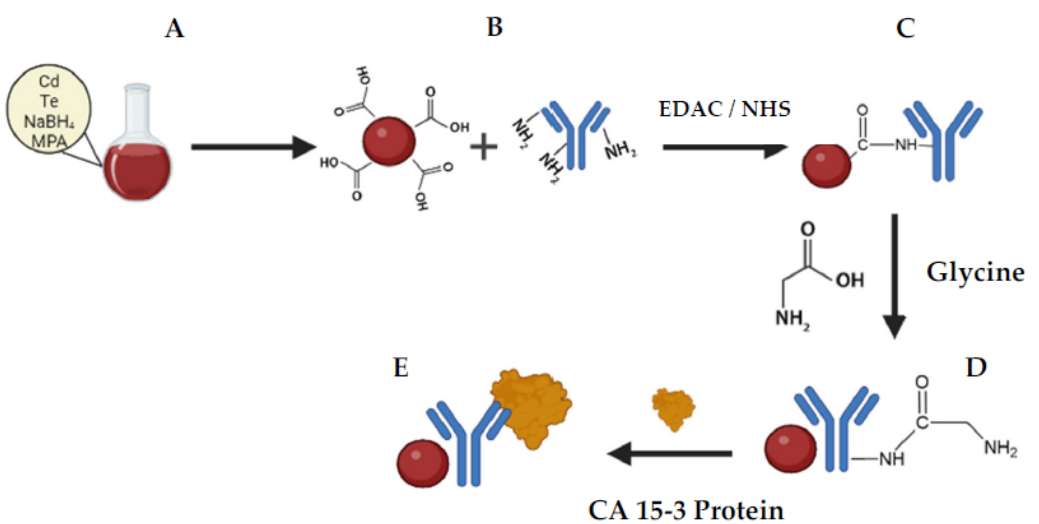
Figure 1. Schematic representation of the synthesis of the QD nanoparticles and preparation of the QD conjugates. ( A ) QD synthesis; ( B ) activation of carboxylic groups from QD; ( C ) covalent bond between the carboxylic groups from the nanoparticles and the amine groups from the antibodies, by the EDAC/NHS reaction; ( D ) blockage of unbound spaces; ( E ) binding of QD conjugates with the CA 15-3 protein.